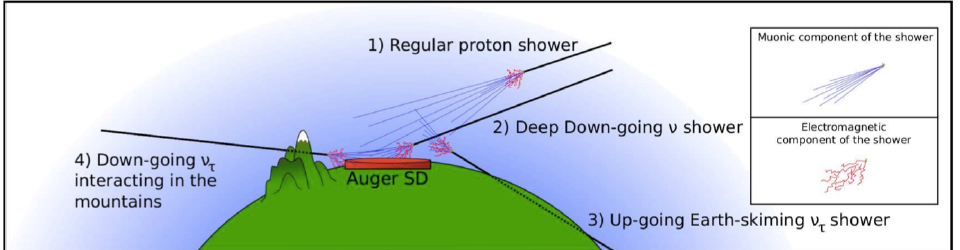
Figure 7: Picture displaying the various neutrino detection modes (2, 3 and 4) in the Pierre Auger surface detector (SD, consisting of water Cherenkov